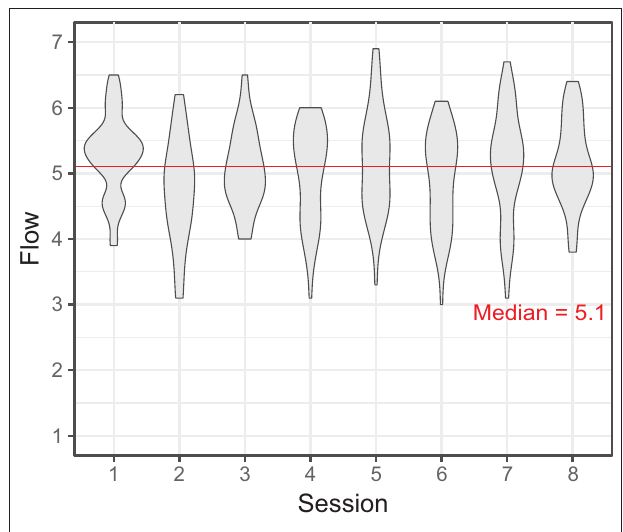
FIGURE 4 | Violin plot representing participants’ self-reported Flow in sessions 1–8 (per-session Flow = mean of five trials. The self-report items are given in Supplementary Information , the scale was